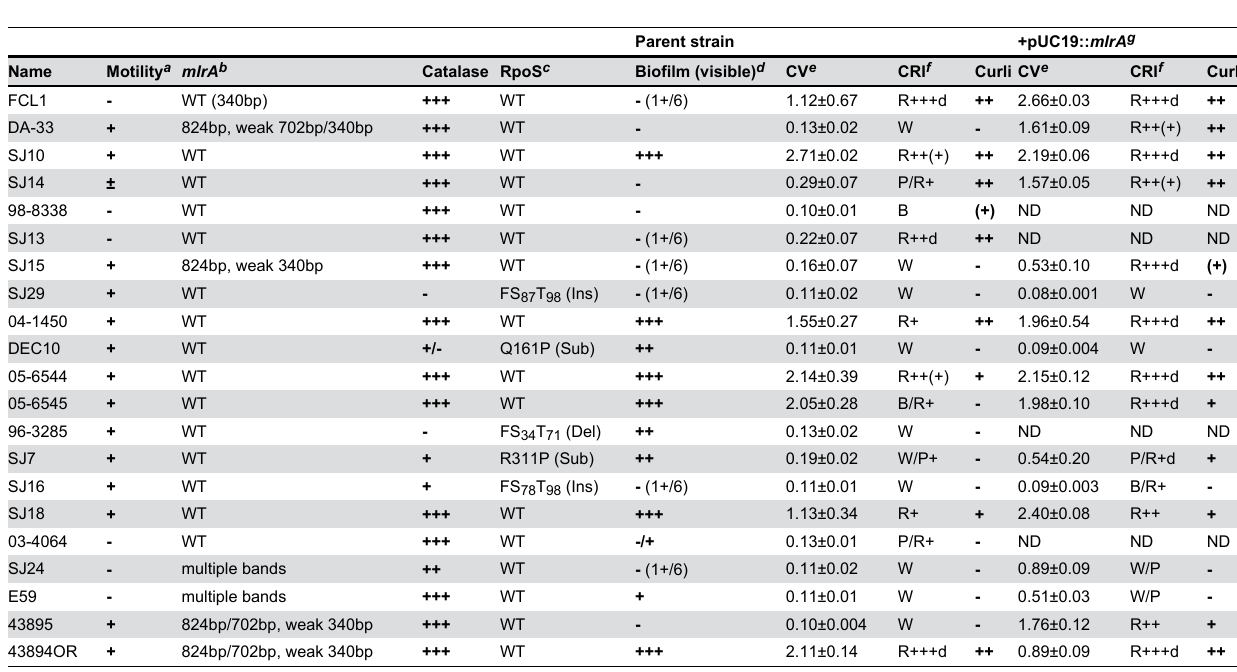
Table 3. Biofilm, crystal violet-, Congo red-binding phenotypes and curli expression of STEC strains with or without complementation by pUC19:: mlrA